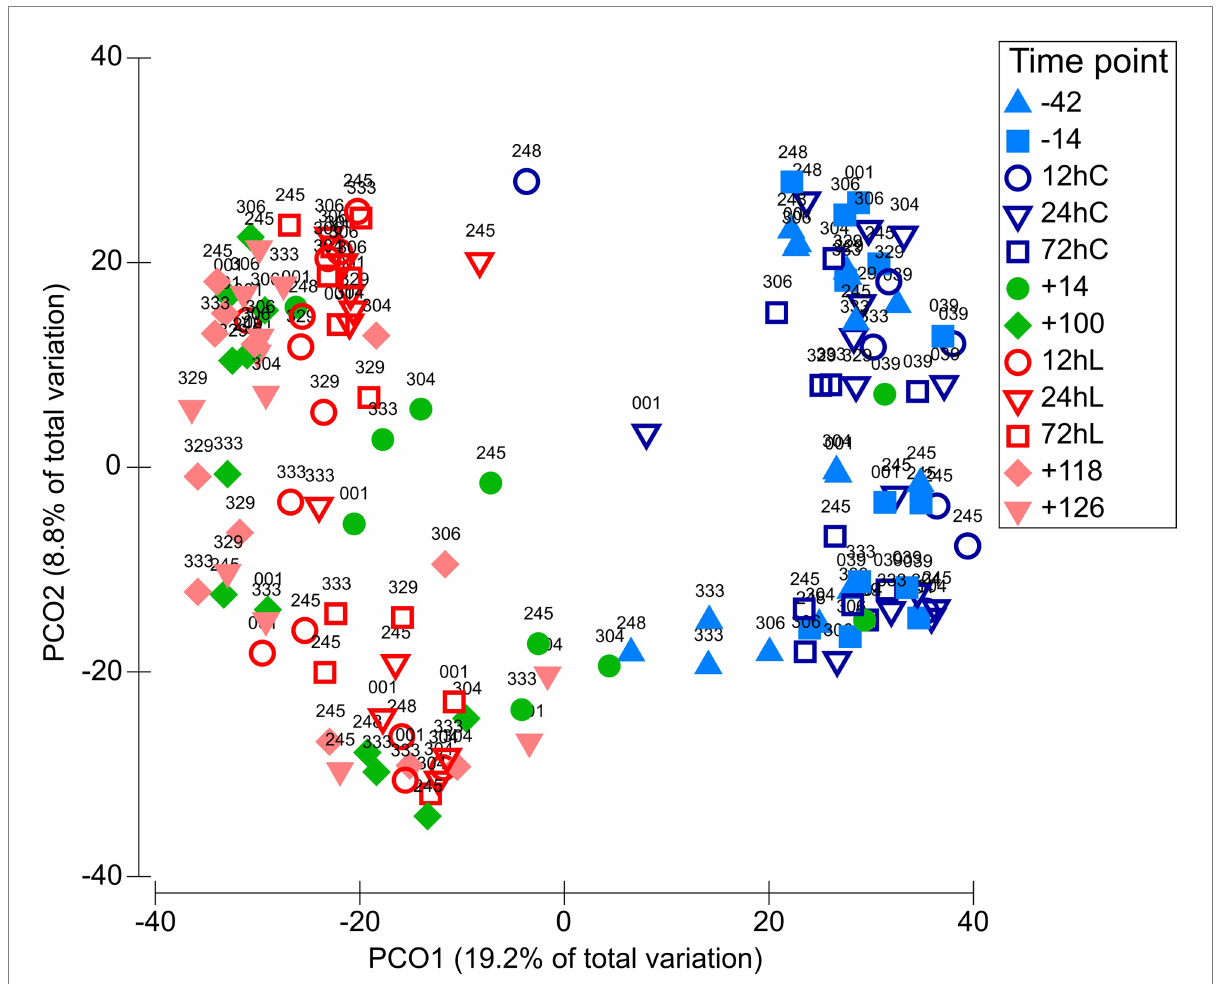
FIGURE 2 Variation of the bacteriome along the full sampling period. PCO plot on OTU level including 143 samples grouped among 12 time points. Matrix definitions are neglected. Time points including a “–” or “+” indicate days antepartum or postpartum and time points including “hC” or “hL” are samples taken at 12, 24, or 72 h after calving or LPS challenge,